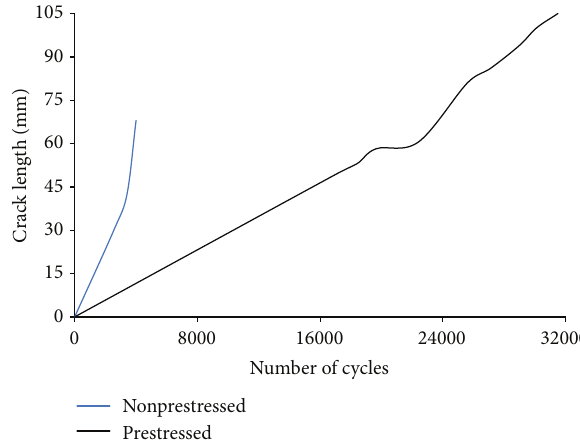
Figure 9: FCG curves for strengthened with nonprestressed and prestressed CFRP plates [63].